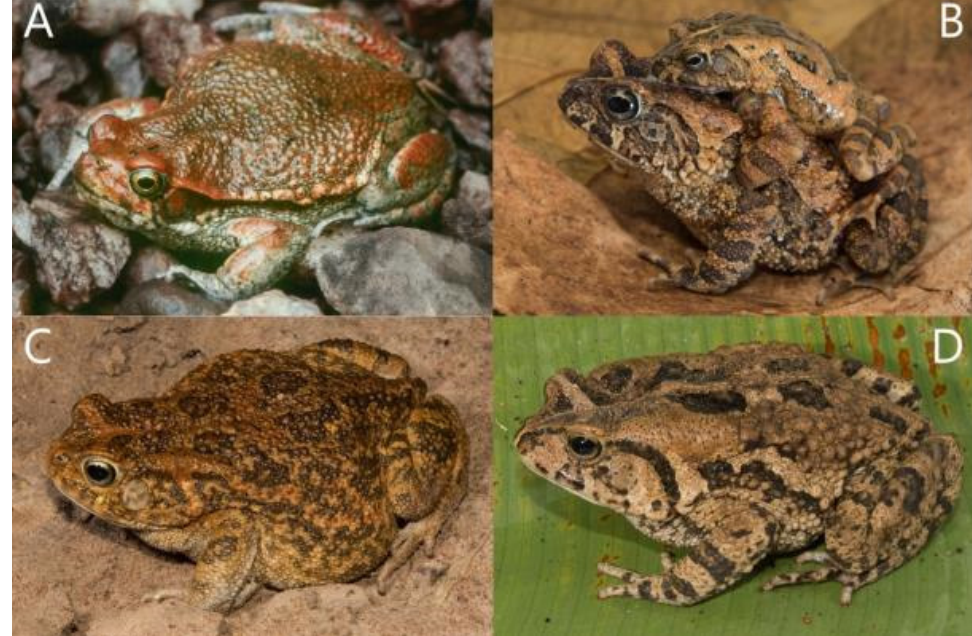
Figure 4. Species of Bufonidae in Rwanda ( A ) Schismaderma carens , Eastern Province (photo: Eberhard Fischer), ( B ) Sclerophrys berghei , Nyungwe NP (photo: J.M.D.), ( C ) Sclerophrys gutturalis , Akagera NP (photo: J.M.D.), ( D ) Sclerophrys kisoloensis , Cyamudongo Forest (photo: J.M.D.).